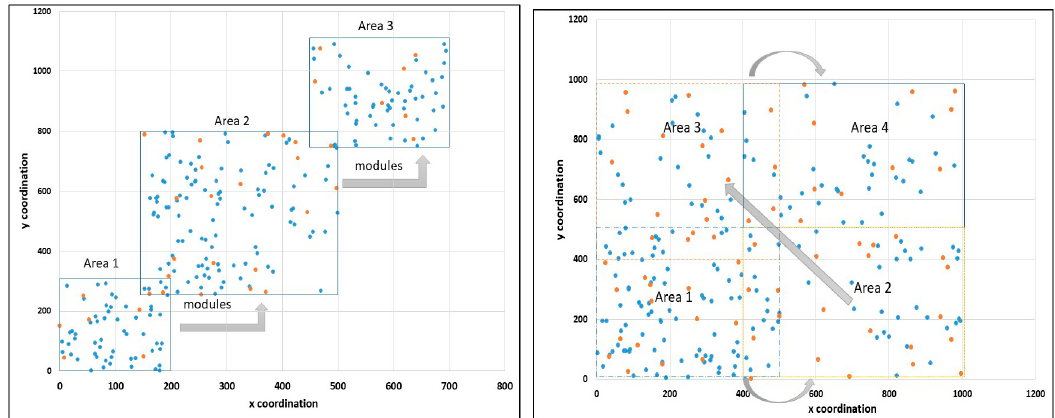
Figure 5. A schematic illustration of three-region and four-region test problems. Table 3. Computational results of test problems for three regions’ experiments.